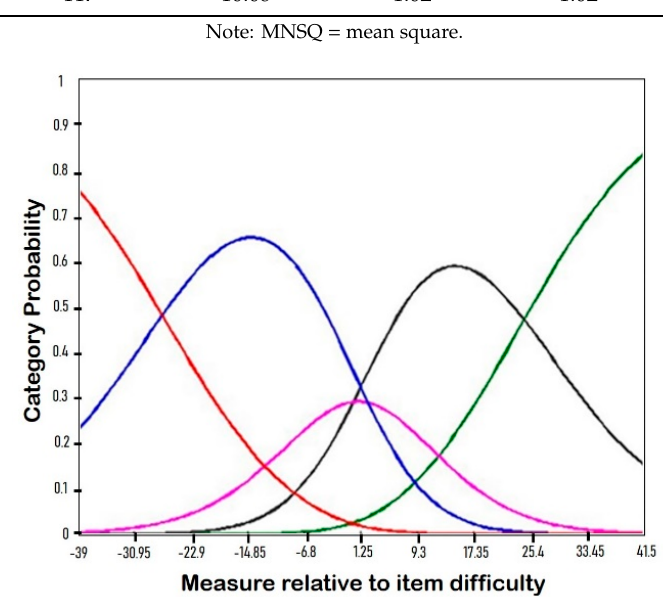
Figure 2. Category probability curve. (Notes: Red line = Category 1; Blue line = Category 2; Pink line = Category 3; Black line = Category 4; Green line = Category 5.).